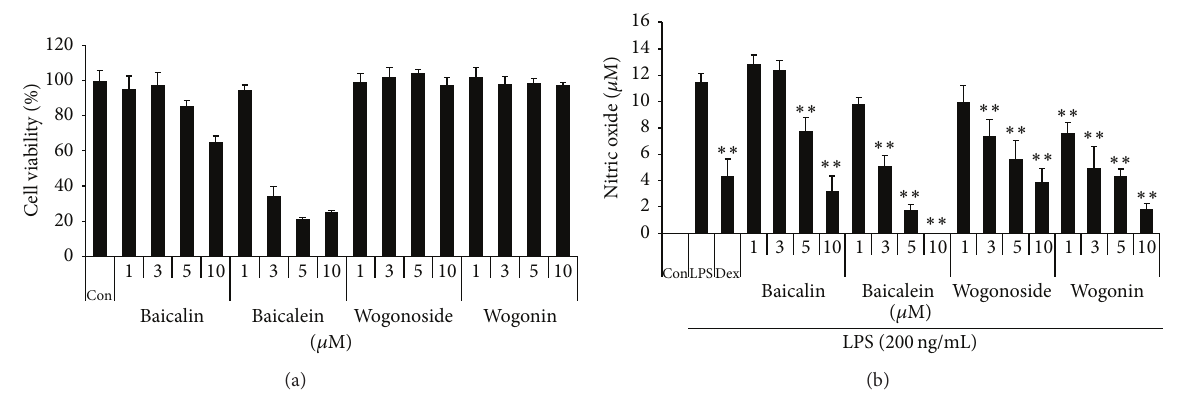
Figure 6: Effect of four compounds on (a) cell viability and LPS-induced (b) NO production in RAW 264.7 cells. RAW 264.7 cells were pretreated with four compounds for 30 min before incubation with LPS for 24 h. (a) Cytotoxicity was evaluated by a CCK. (b) The culture supernatant was analyzed for nitrite production. As a control, the cells were incubated with vehicle alone. Data shows mean ± SE values of triplicate determination from independent experiments. ∗ 𝑃 < 0.01 and ∗∗ 𝑃 < 0.001 were calculated from comparing with LPS-stimulation